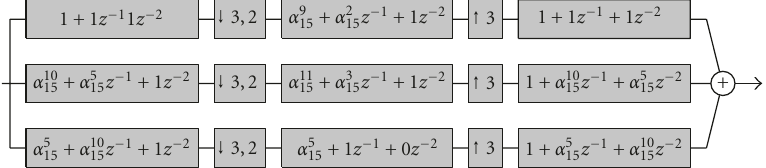
Figure 3: Filter bank with component codes in each subband for the R [15,10] (Example 3).